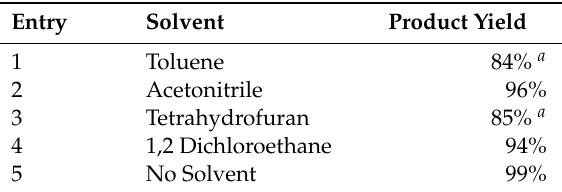
Table 1. Solvent Table 1. Solvent evaluation.